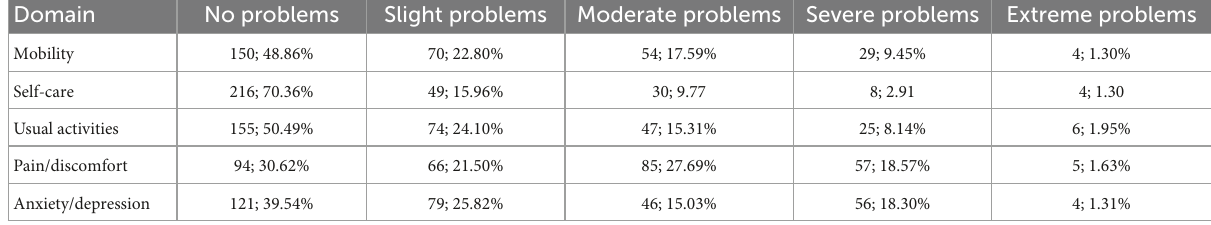
TABLE 2 Results of the EQ-5D-5L assessment.